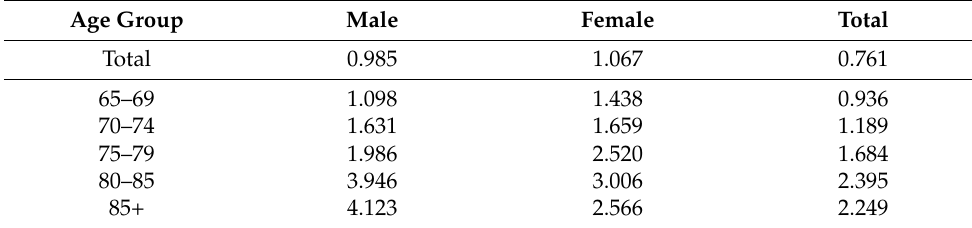
Table A3. IAFA sampling errors by sex and age group.